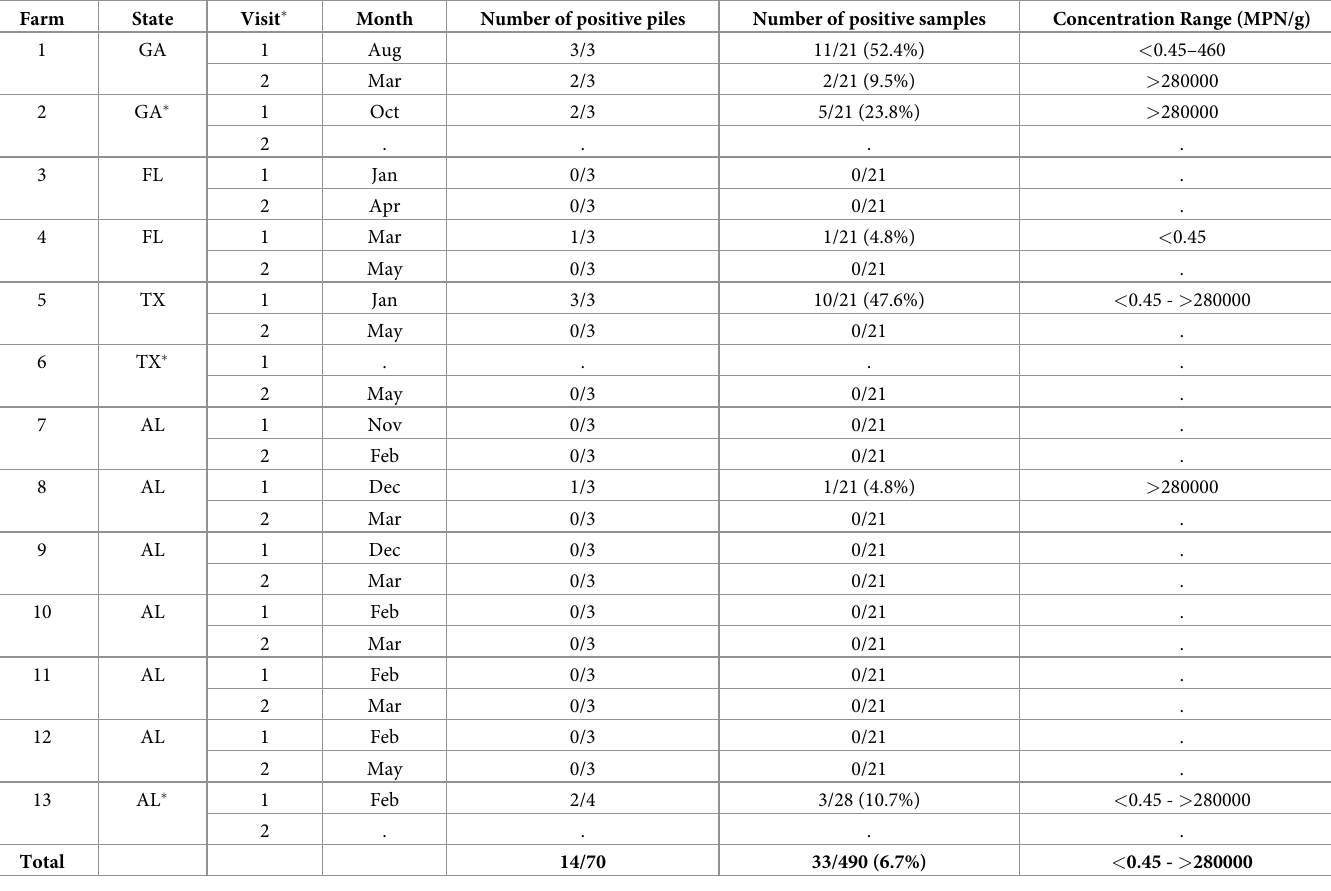
Table 1. Number and concentration of Salmonella -positive piles and samples from each farm sampling. Sample concentration for positive samples reported in most probable number per gram (MPN/g).